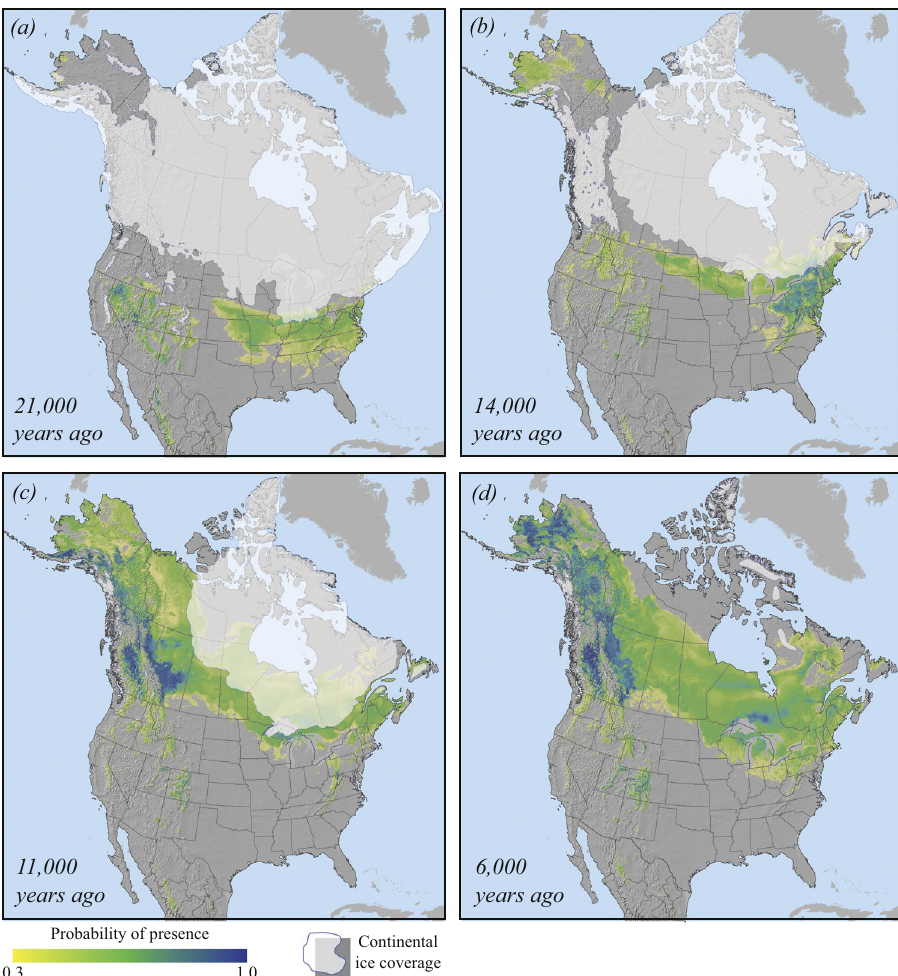
Figure 3. Palaeoclimatic habitat projections for trembling aspen based on the CCM1 general circulation model for ( a ) 21,000 years before present, ( b ) 14,000 years before present, ( c ) 11,000 years before present and ( d ) 6,000 years before present. The maps were created with ArcGIS v9.3